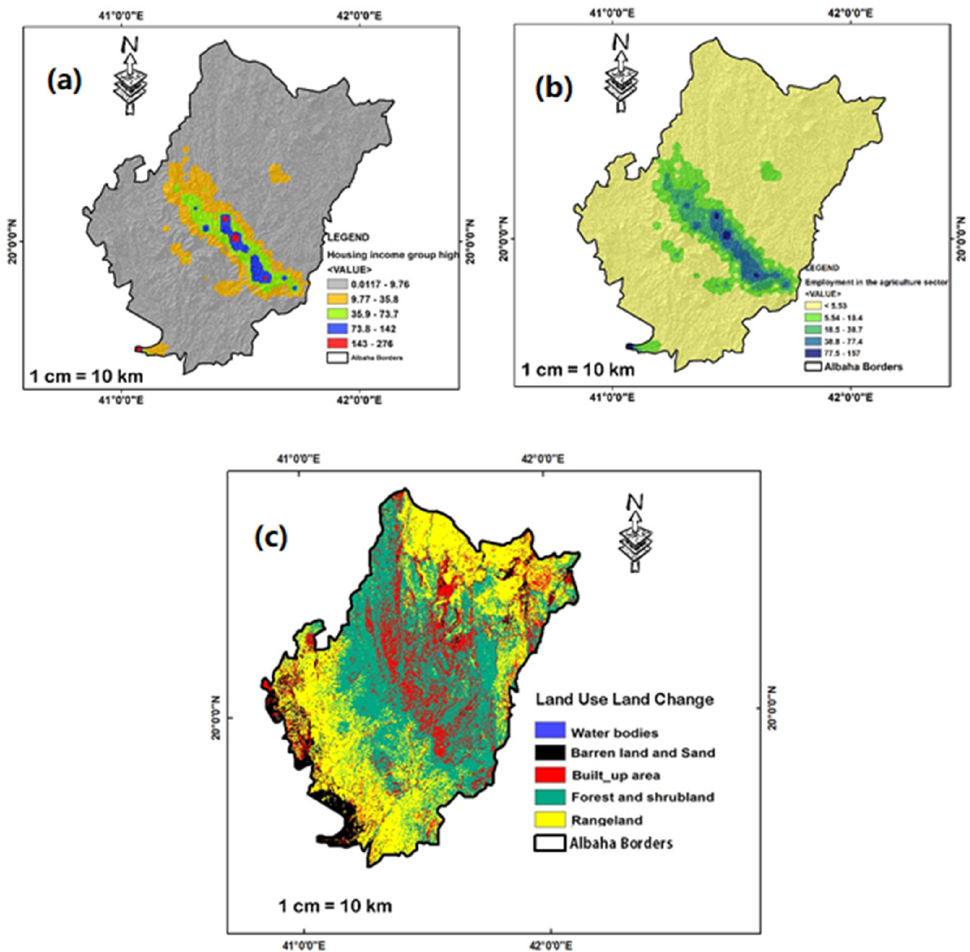
Figure 4. Representation of ( a ) housing high-income group map, ( b ) employment in the agriculture sector, and ( c ) land use land change.